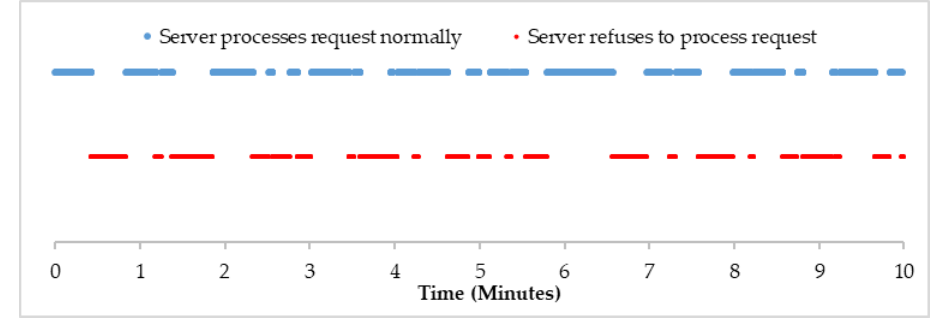
Figure 13. Time-series diagram of the login attempts of a single-server IP.